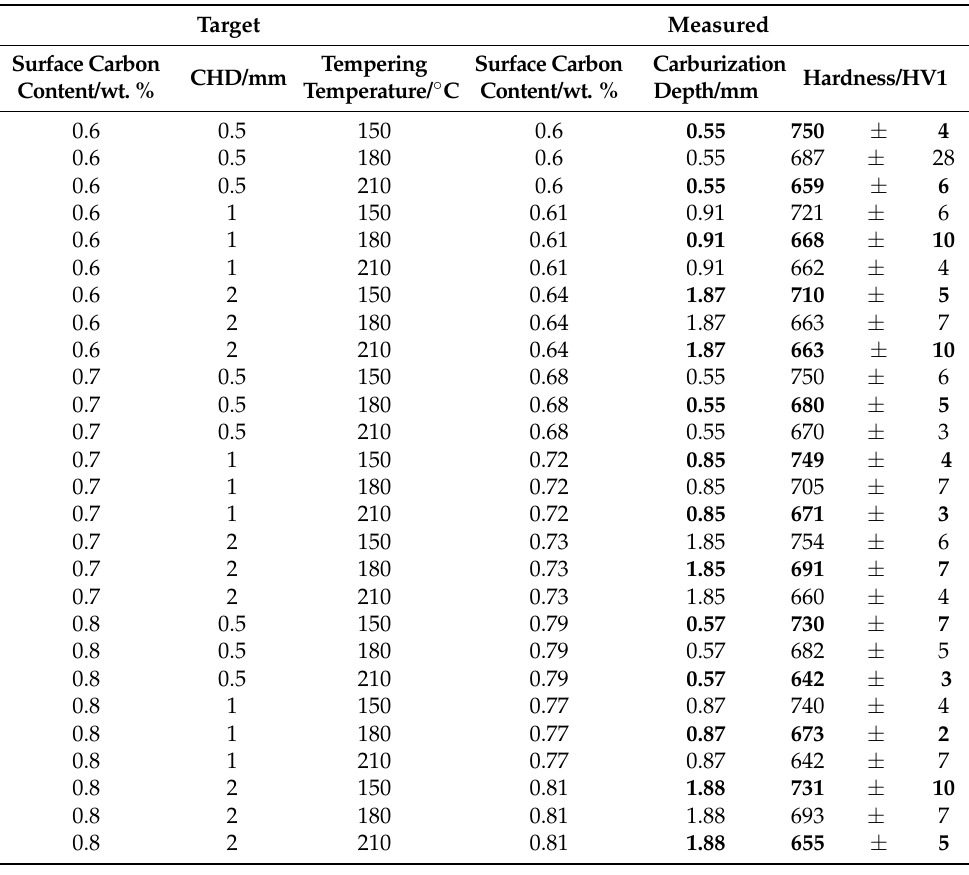
Table A1. Measured surface carbon content, carburization depth and hardness of the 27 heat treatment variations; bold printed results were used for the validation in Figure 15 and Table 11. Target